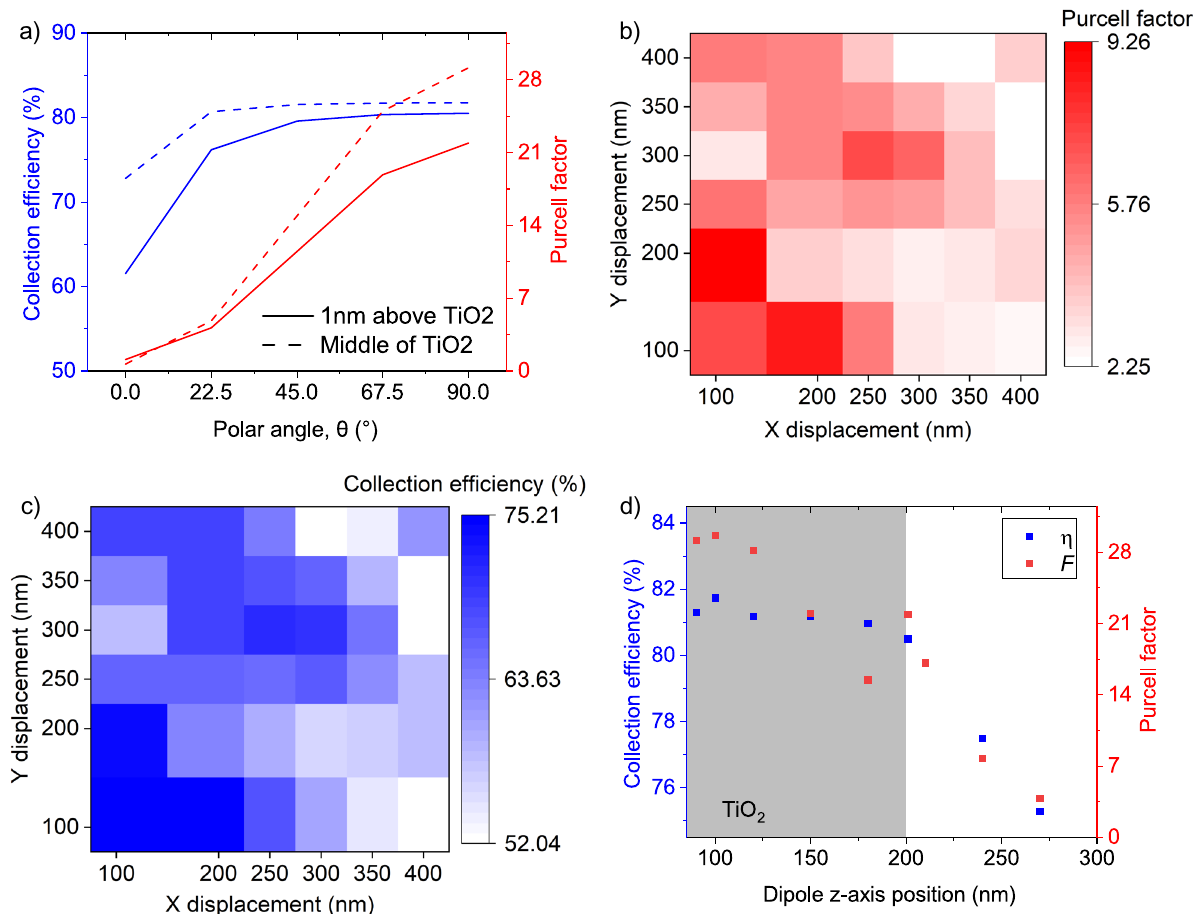
Figure 3. The effect of dipole orientation and displacement in the Bullseye cavity. ( a ) The Purcell factor as a function of the polar angle of the dipole. 0° and 90° represent out-of-plane and in-plane dipoles, respectively. ( b ) Purcell factor as a function of the dipole displacement in x and y-direction. ( c ) Collection efficiency as a function of the dipole displacement in x and y-direction. ( d ) Collection efficiency (left y-axis) and Purcell factor (right y-axis) as a function of the dipole position along the z-axis (x = y = 0). The system resonates at 752 nm. Number of rings in both simulations is